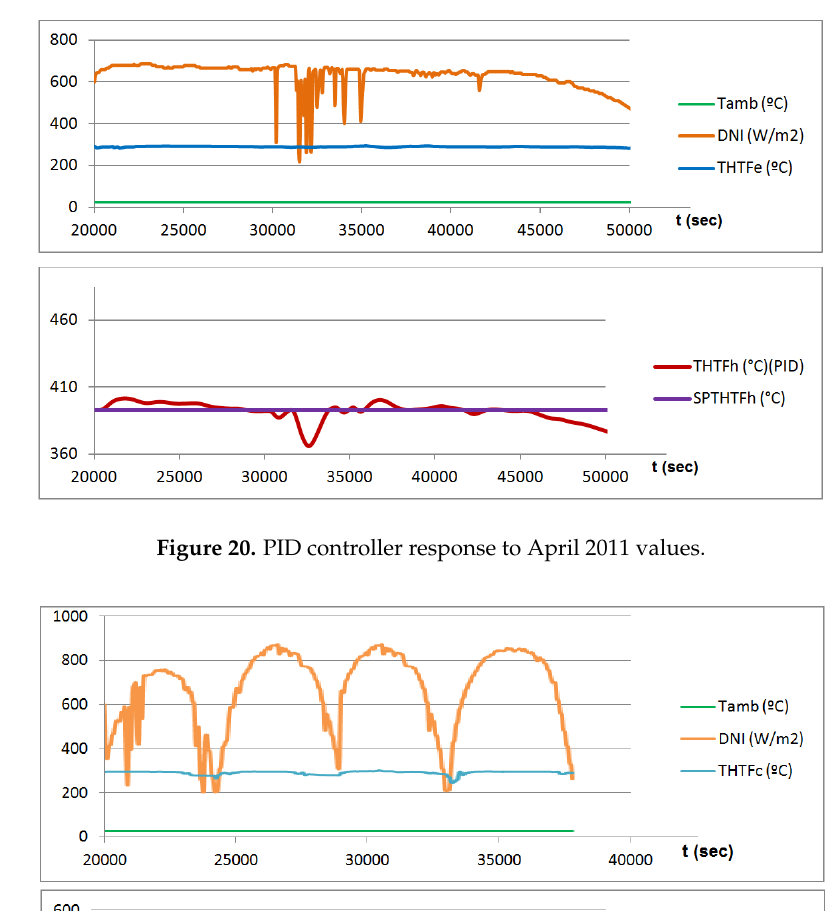
Figure 19. PID controller response to September 2010 values.